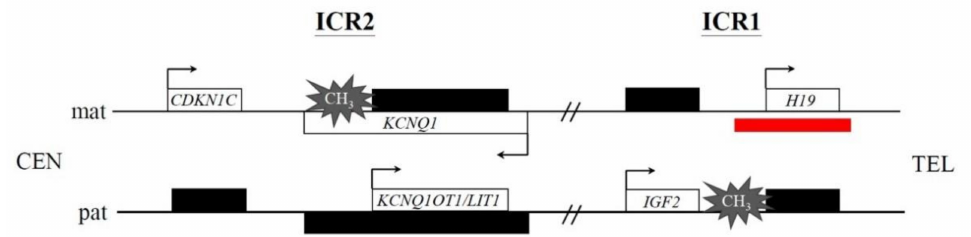
Figure 1. Molecular etiology of Beckwith–Wiedemann syndrome (BWS). Schematic representation of the two neighboring imprinted domains at human chromosome 11p15.4p15.5, namely imprinting control region 1 (ICR1) and ICR2, related to BWS. Active gene indicated by white symbol, inactive gene by black symbol, differentially methylated region by gray symbol, and direction of transcription by arrow. The maternal and paternal alleles by “mat” and “pat”, respectively. CEN, centromere; TEL, telomere. The red bar indicates the 11p15.5 deletion detected in our Patient 3 (case III-9 in Figure 2) that covers the ICR1 of the maternal